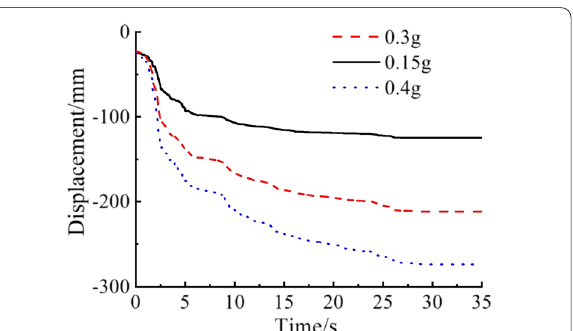
Fig. 12 Time history curve illustrating vertical subsidence of soil due to El Centro ground motion with various